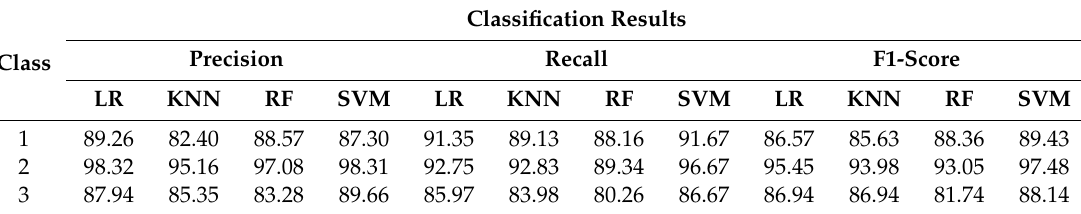
Table 3. Comparative analysis of di ff erent classification models (%).